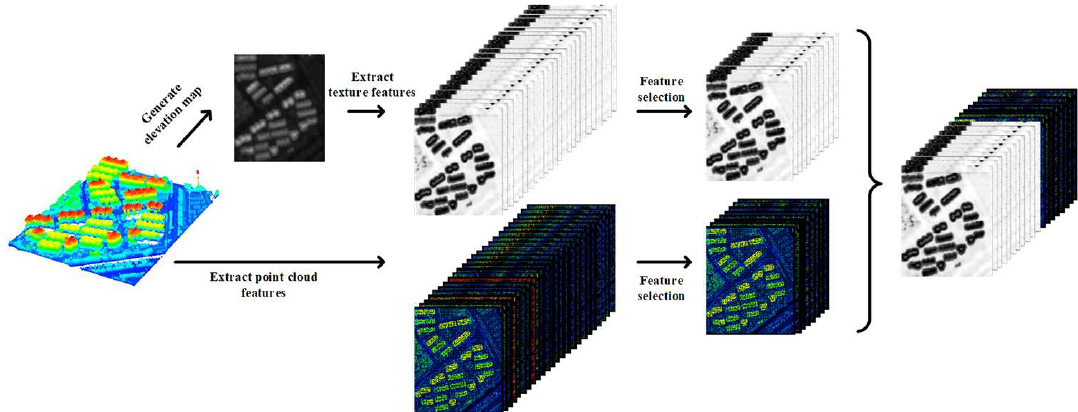
Figure 2. The process to obtain the optimal combination of